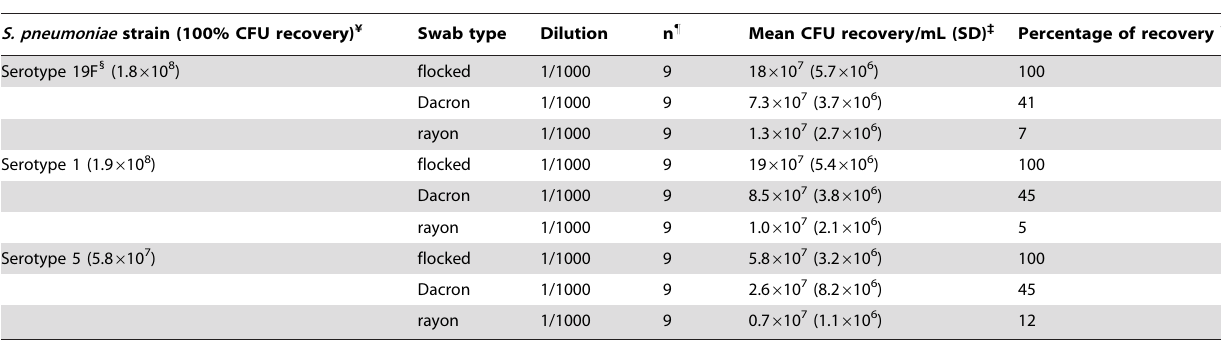
Table 1. Recovery of Streptococcus pneumoniae from mock specimens using flocked, Dacron and rayon swabs.